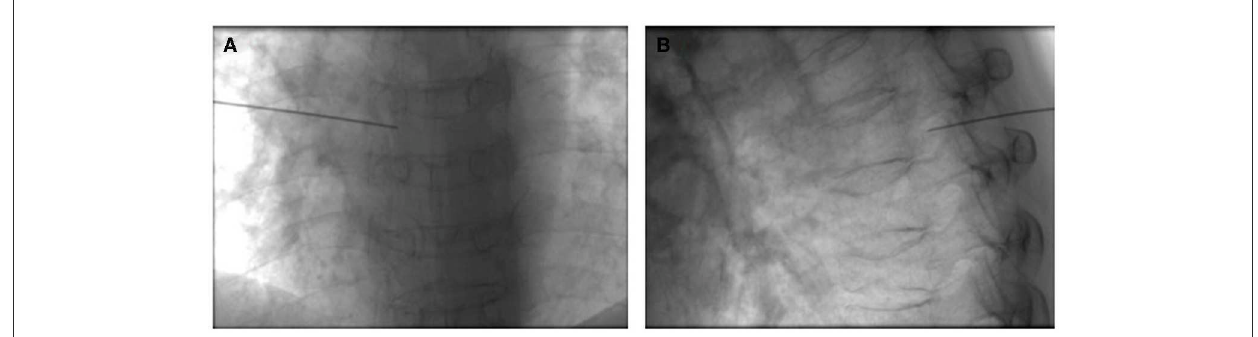
FIGURE3 PRF treatment based on the C-SSVB treatment. Confirmation of the position of the RF target to the dorsal root ganglion in the (A) front and (B) side position of the spinal cord.